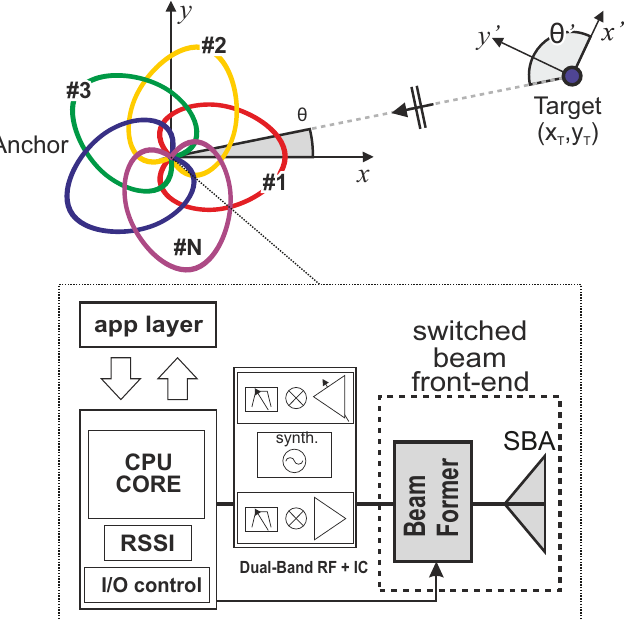
Figure 1. Architecture of the proposed anchor device, based on the one defined in [16] and overview of the localization